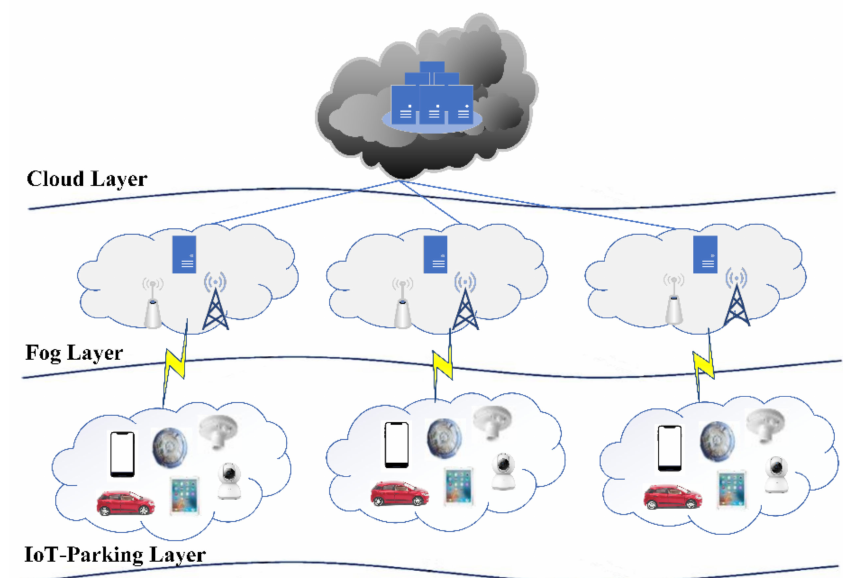
Figure 2. Multi-layer parking system